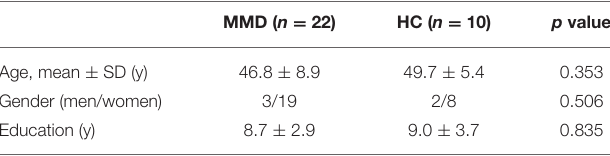
TABLE 1 | Baseline characteristics between MMD and